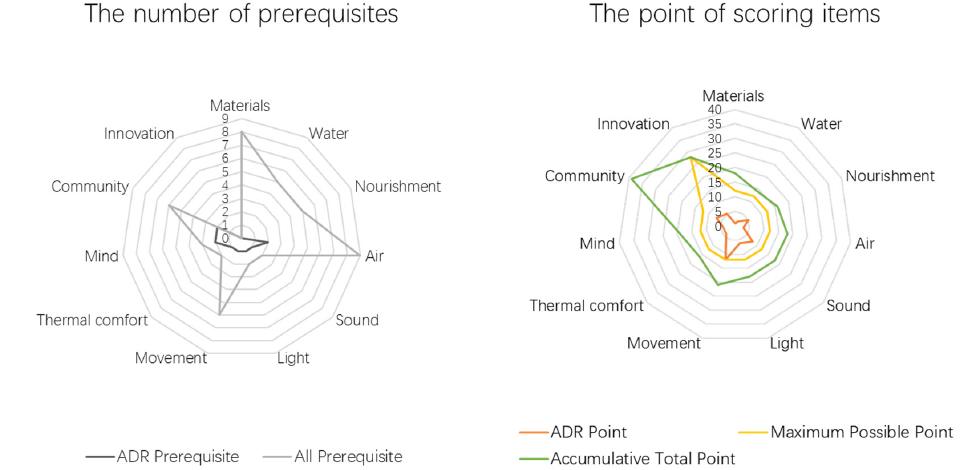
Figure A3. Breakdown of the number of prerequisites, the point of scoring items, and ADR ratios in diverse categories of GM. (Source: by the author).